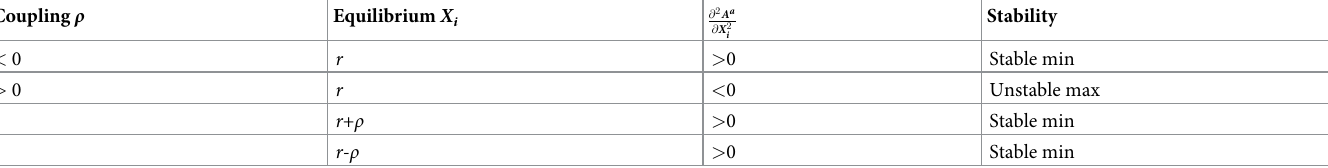
Table 1. Equilibrium position and